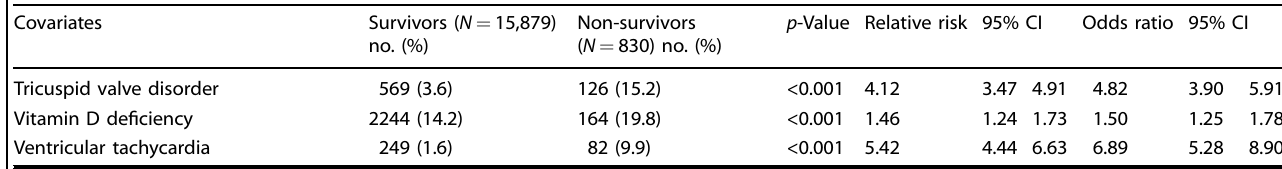
Difference in the mortality probabilities between the group with the condition (or demographic status) and the no-condition group.